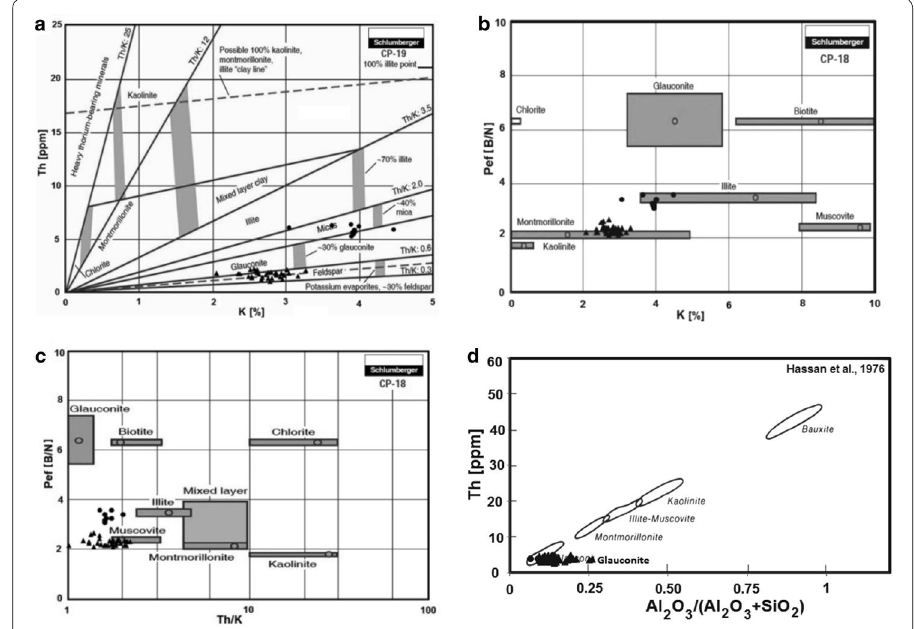
Fig. 11 The results of log-derived clay typing: a Th (vs) K, from Schlumberger [41]; b PEF (vs) K, from Schlum- berger [41]; c PEF (vs) Th/K, from Schlumberger [41]; d Th (vs) Al 2 O 3 /(Al 2 O 3 producing well data points, and black up-pointing triangle non-producing well data